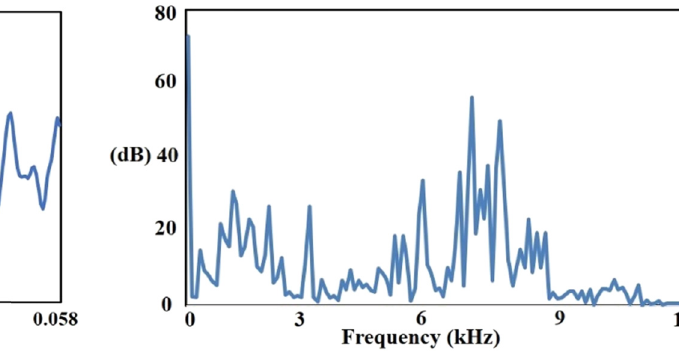
Figure 16: Time domain signal ( normal bearing ) .